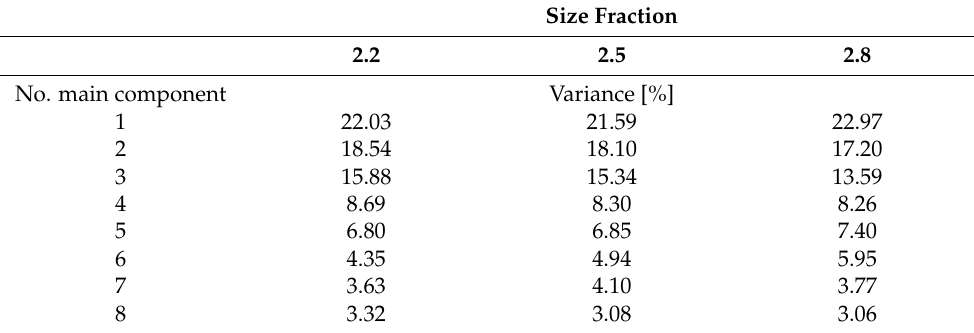
Table 3. Values of variances explained for 8 consecutive principal components.